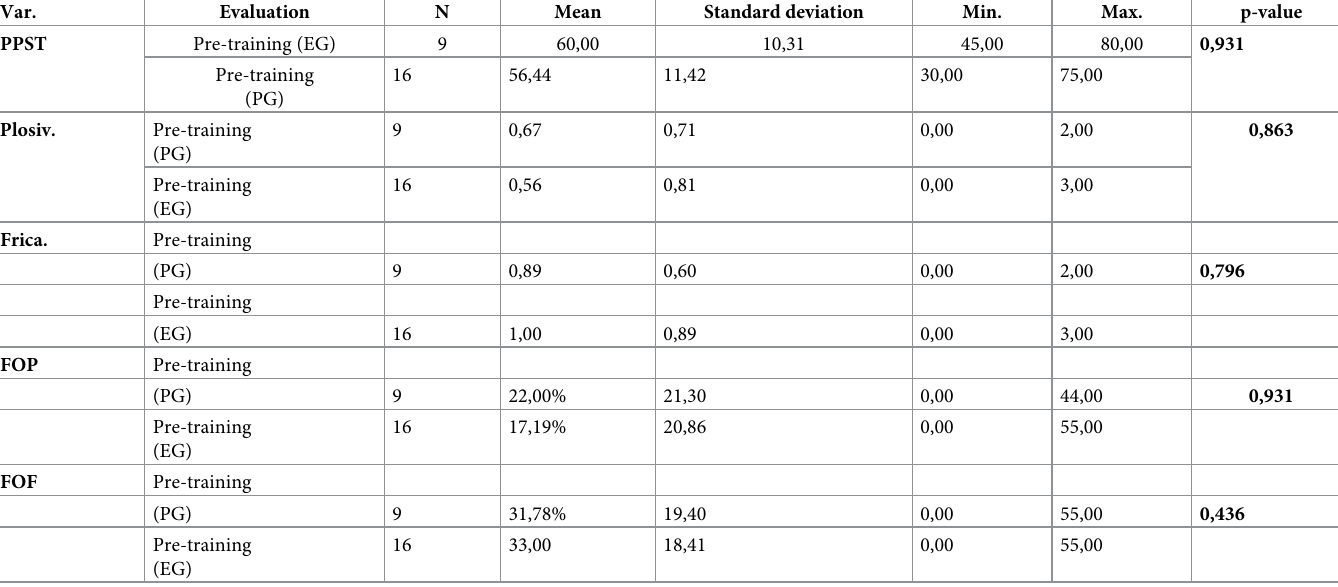
Table 1. Comparison between the variables before each type of training.